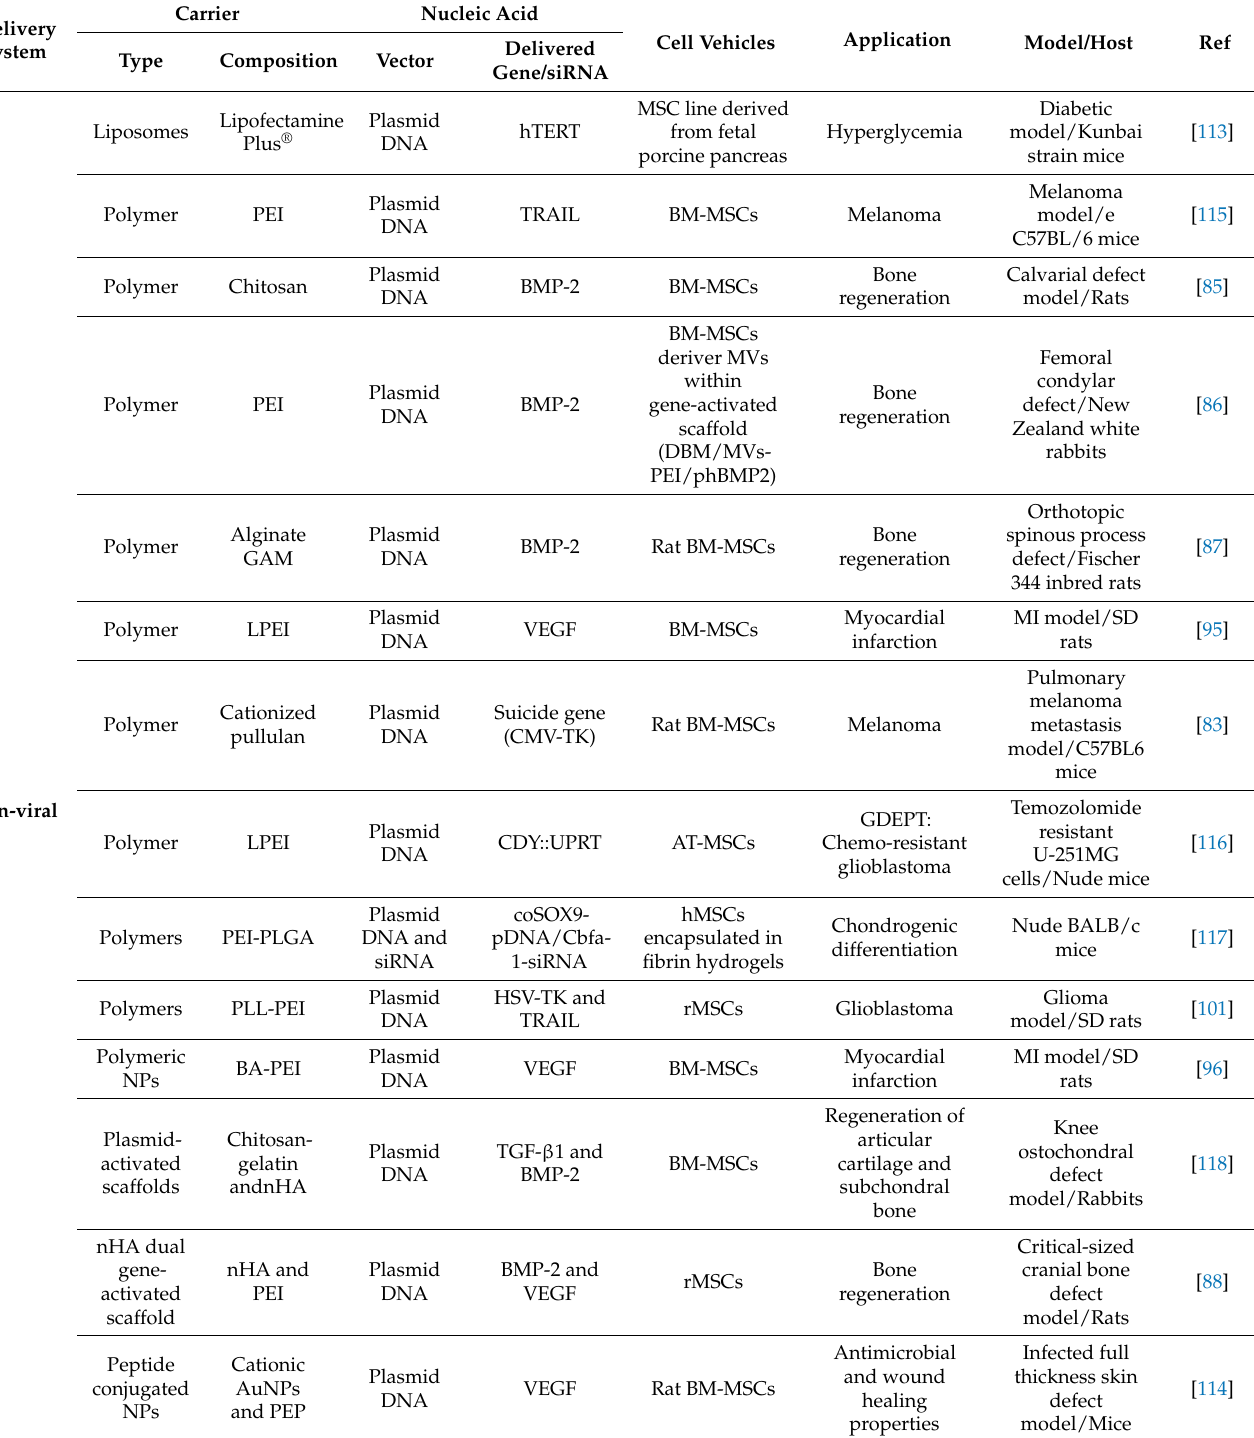
Table 4. Applications of genetically modified MSCs in